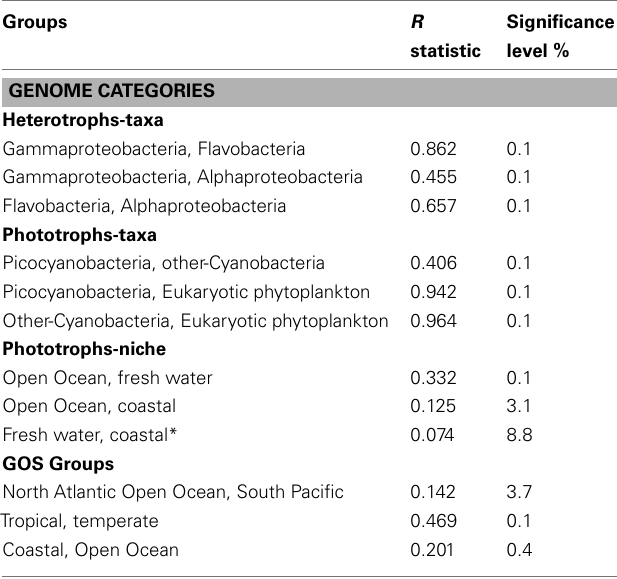
Table 2 | Statistical comparison (ANOSIM) of Fe-metabolism systems in various groupings of genomes and